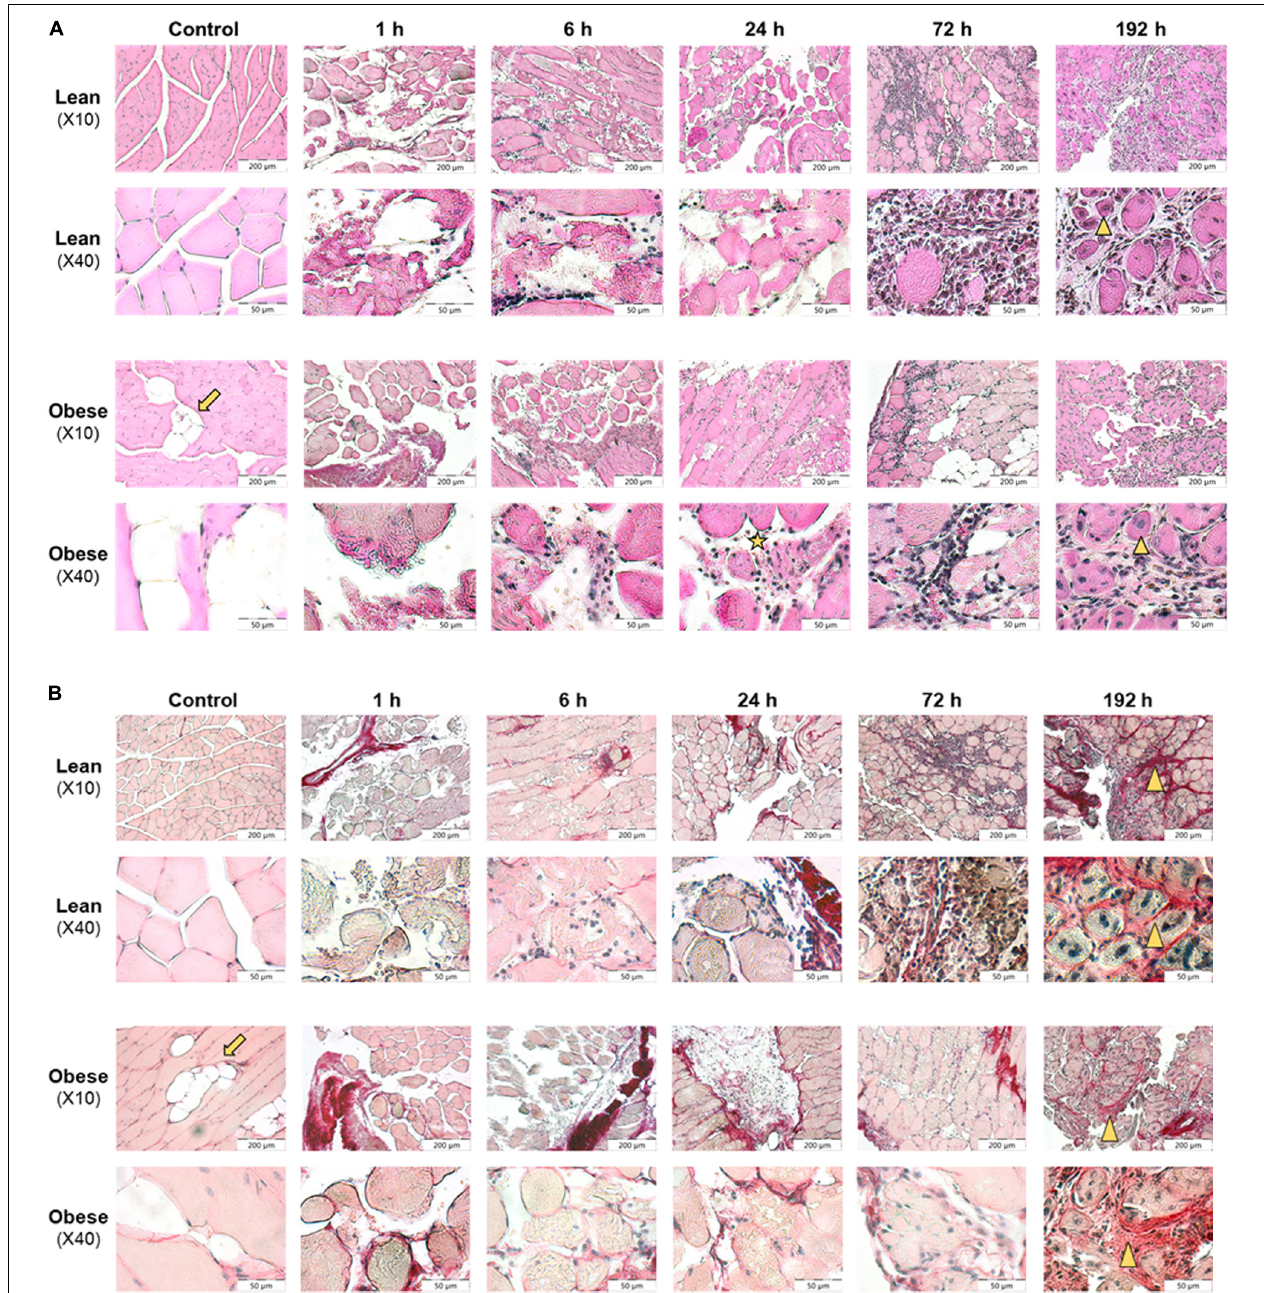
FIGURE 4 | Restricted regeneration of the muscle extensor iliotibialis anticus and decreased density of the regenerated tissue in obese mice 192 h post trauma induction. Histology of regeneration process in muscle extensor iliotibialis anticus of male lean and obese C57BL/6J mice after induction of blunt injury ( n = 6). (A) Hematoxylin and eosin (HE) staining of muscle tissue sections from control mice as well as 1, 6, 24, 72, and 192 h post trauma. Obese mice show fat deposition (arrow) between muscle fibers. Blunt injury led to disruption of muscle fibers and influx of erythrocytes and immune cells. Further, necrotic muscle fibers were visible (asterisk). 192 h post trauma newly formed myofibers with centered nuclei could be identified (triangle). (B) Sirius red (SR) staining of muscle tissue sections from control mice as well as 1, 6, 24, 72, and 192 h post trauma. Interstitial collagen deposition (triangle) was visible 192 h post injury in lean and obese mice. Pictures were taken with the UC30 color camera at X10 and X40 magnification (OLYMPUS IX81). Scale bar: 200 µ m (X10), 50 µ m (X40).